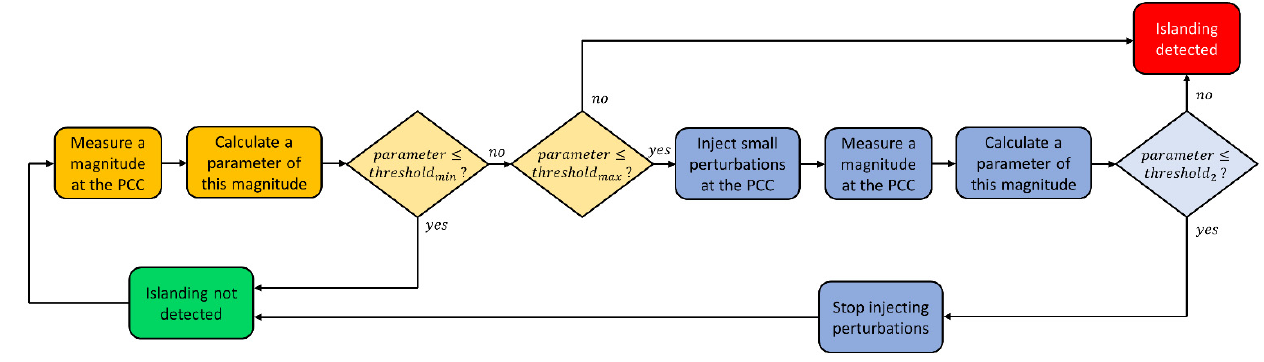
Figure 9. General scheme of hybrid methods.